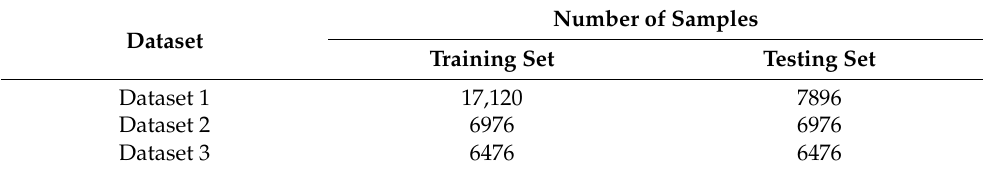
Table 7. The number of samples in the training set and testing set of three